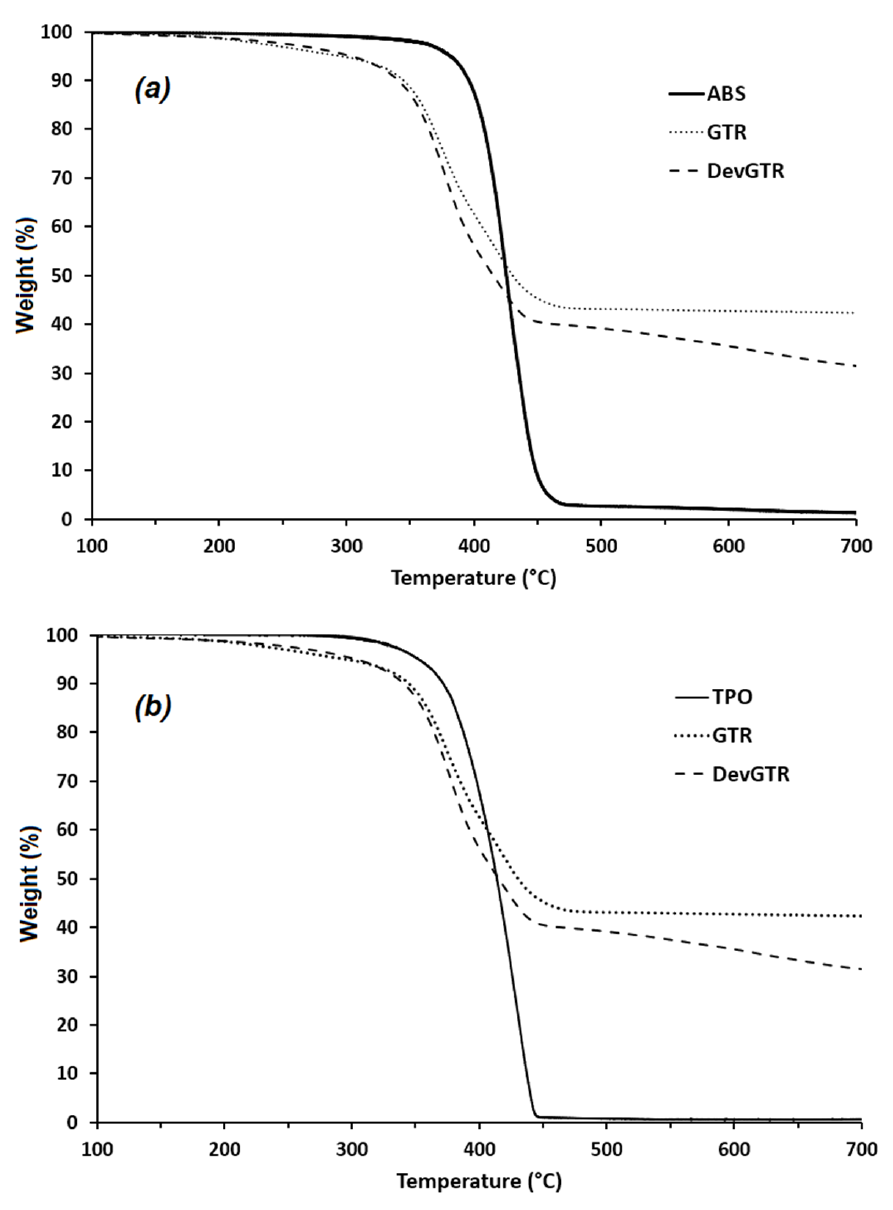
Figure 2. TGA thermograms of vulcanized (GTR), devulcanized (DevGTR) recycled tire rubber powders and ABS ( a ) and TPO ( b ) (under N 2 , 10 °C/min).